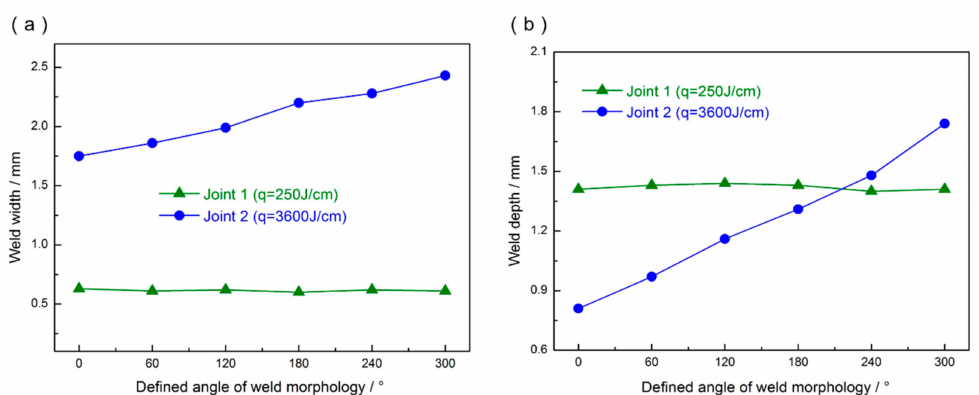
Figure 7. Change in: ( a ) width and ( b ) depth of the fusion zone for laser-welded NS Mo alloy joints along the weld